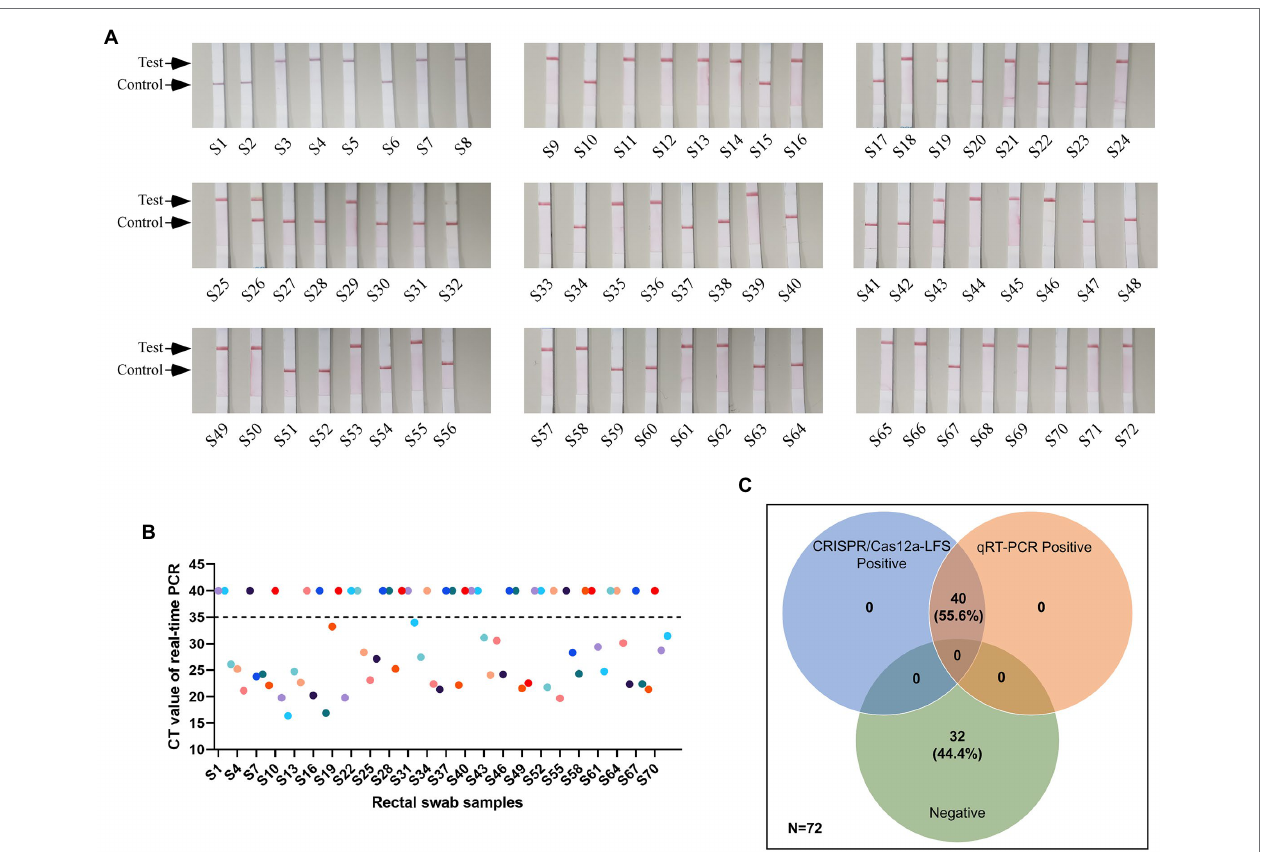
FIGURE 5 | Detection results of clinical samples. (A) Detection of PEDV cDNA in 72 rectal swab samples using CRISPR/Cas12a-LFS. The test line and control line on the lateral strip were marked with arrows. (B) Detection of PEDV cDNA in 72 rectal swab samples using quantitative real-time PCR (qRT-PCR). (C) The